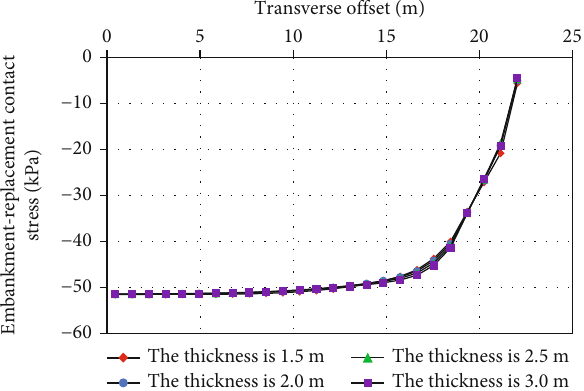
Figure 9: Transverse distribution of embankment-replacement contact stress with di ff erent thicknesses of